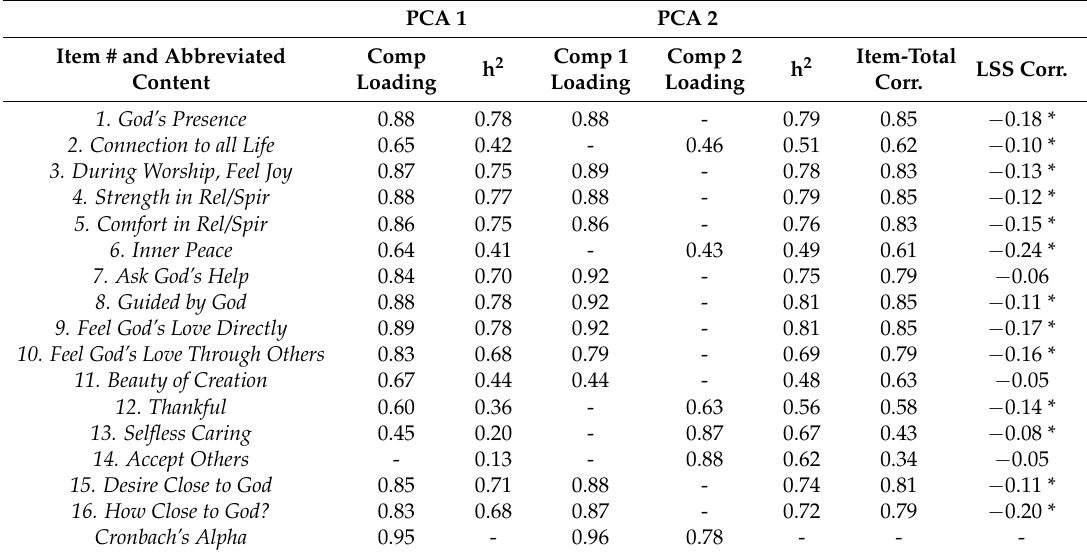
Table 1. Results from principle components analysis (PCA) 1 and PCA 2 and Item Correlations with Langner Symptom Survey (LSS) Total.